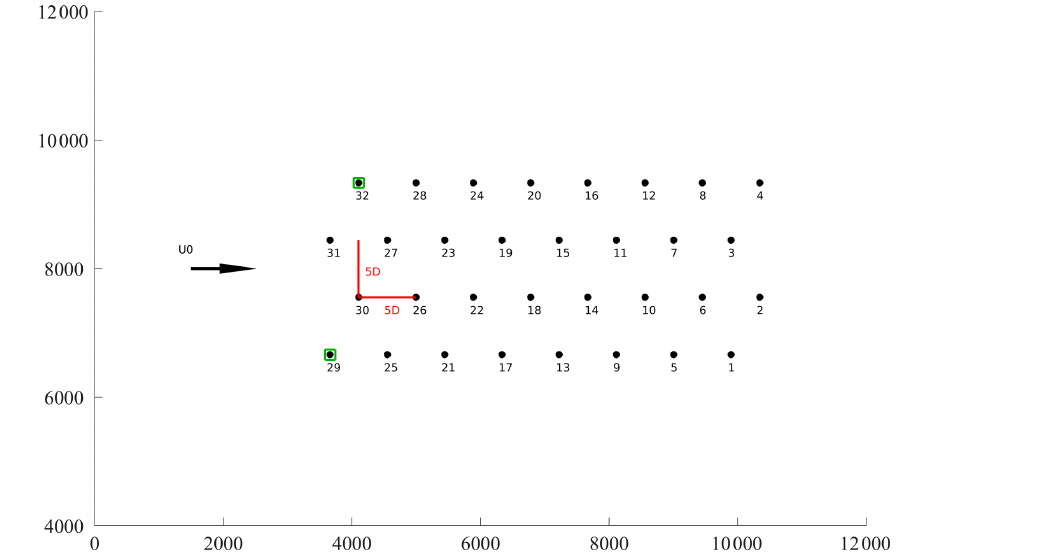
Figure 20. Layout of the TotalControl reference wind farm with a wind direction of 90 ◦ . Green squares mark yawed turbines. The turbine IDs are referred to as WT1, WT2, ... , WT32 throughout the rest of the section.